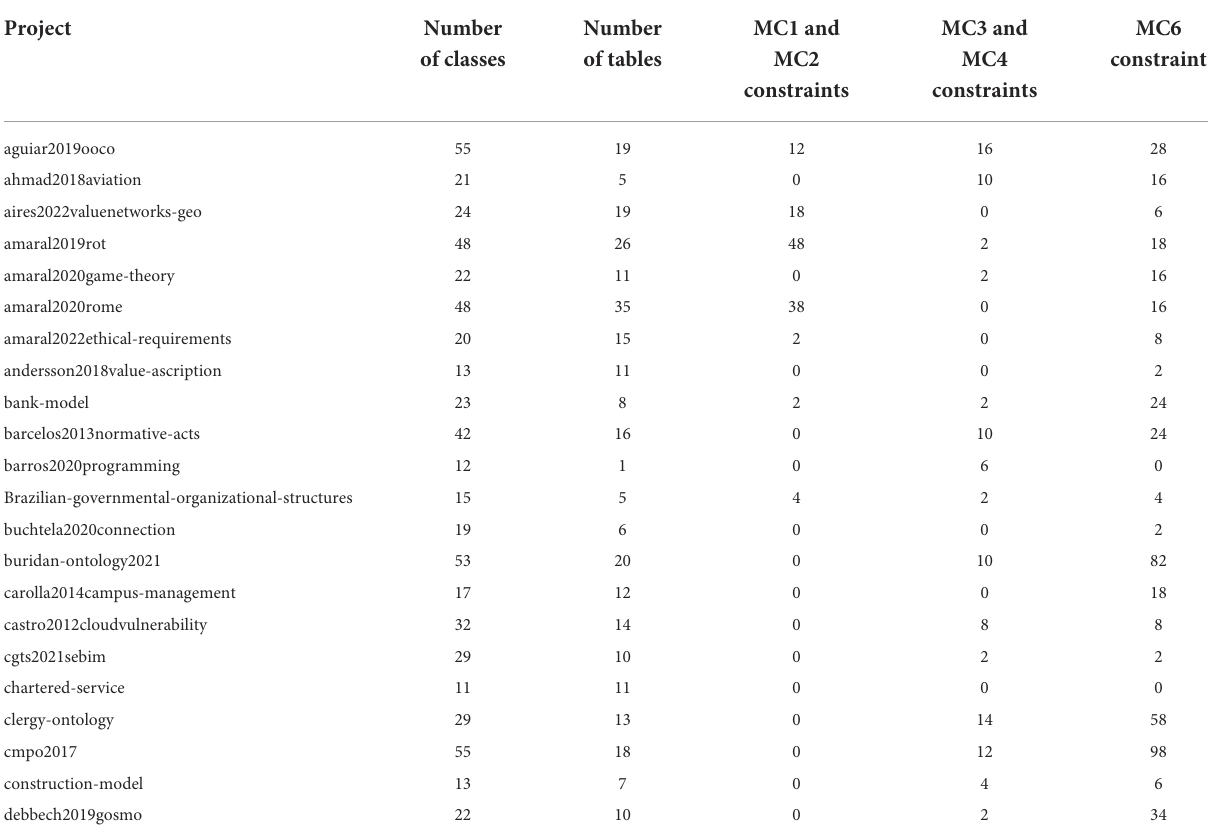
TABLE 4 Transformation process